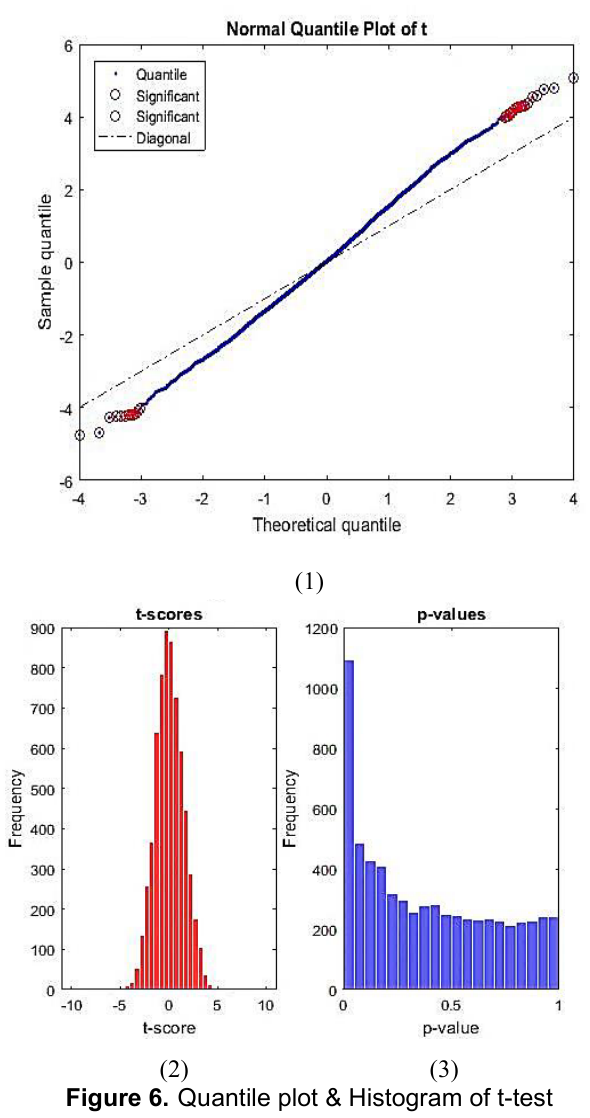
Figure 6. Quantile plot & Histogram of t-test Table 2. P and q- values for annotated